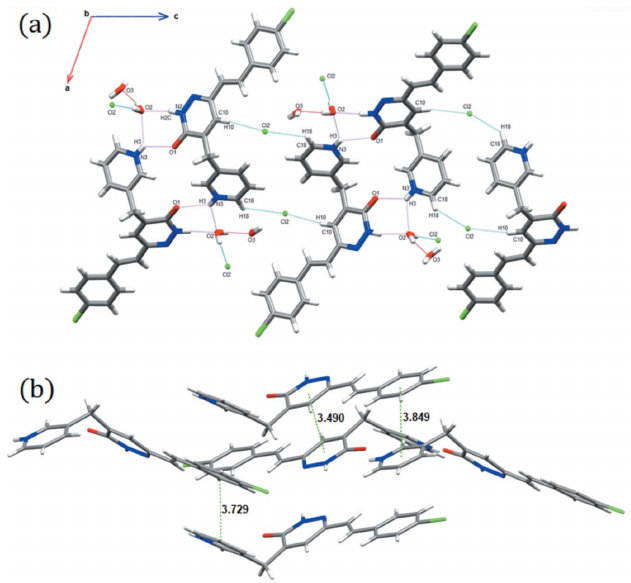
Figure 2 ( a )View along the b axis of the unit cell showing the molecular sheets. ( b ) (cid:2) – (cid:2) interactions.